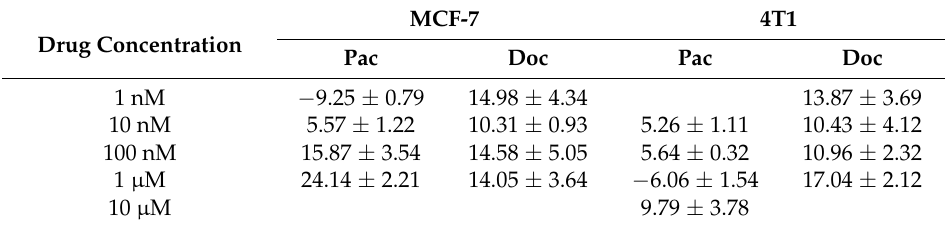
Table 3. Enhancement in cytotoxicity (%) of CA complexed drug vs. free drug on 4T1 and MCF-7 cells. Drug Concentration Pac